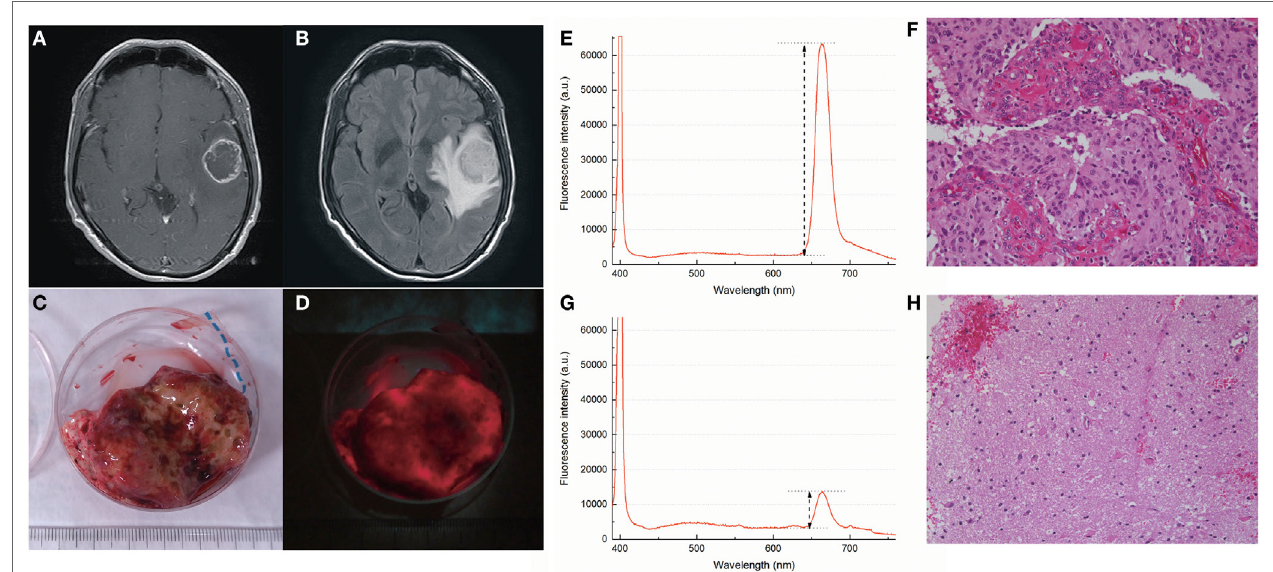
FigUre 8 | Illustrative case. A 47-year-old male with newly diagnosed glioblastoma multiforme (GBM) in the left temporal lobe. (a) Preoperative T1-weighted MR image with contrast showed a tumor in the left temporal lobe with ring-like enhancement (CE region). (b) Preoperative FLAIR image revealed severe peripheral edema (NCE region) surrounding the tumor mass. (c,D) Intraoperative images of the resected tumor under white light (c) and blue laser (D) observed through an optical filter (460 nm long pass). Bright red fluorescence was confirmed, particularly around the rim area that corresponded to the CE region. (e,F) Spectrum and hematoxylin and eosin stained section (original magnification × 200) obtained from the CE region. The sharp peak at 400 nm was from the excitation laser and the wider peak at 664 nm was from the TS fluorescence (e) . Fluorescence intensity was calculated as the peak height (arrows) minus the baseline value at 600 nm (dotted line at the bottom). Abundant tumor cell invasion and endothelial proliferation was seen (F) . (g,h) The same data obtained from the NCE region. Compared to the CE region, a lower fluorescence intensity (g) and reduced cellularity with normal brain tissue (h) were observed. a.u., arbitrary units; CE, contrast-enhanced; NCE, non-contrast-enhanced; TS, talaporfin sodium.